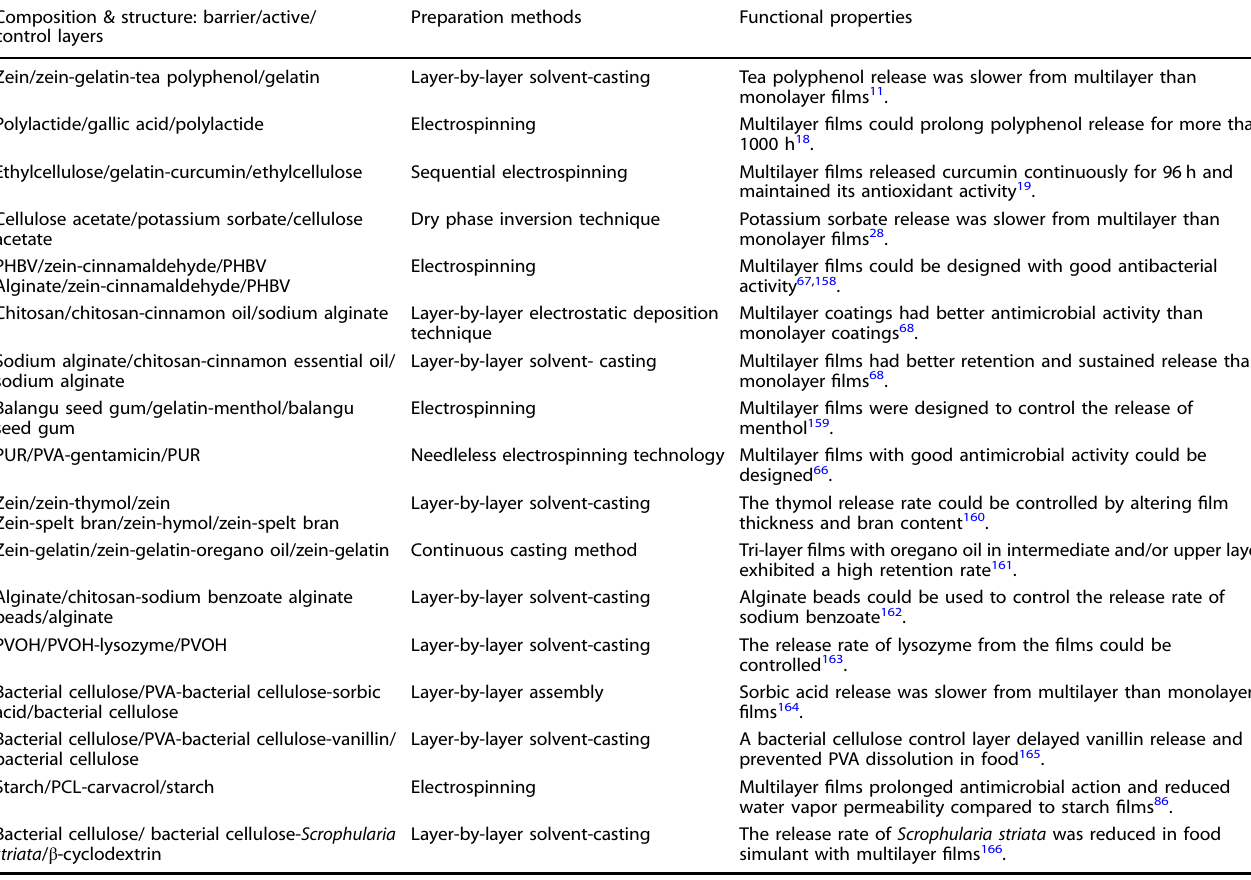
Table 2. Representative examples of previous research on degradable multilayer packaging materials with different compositions.